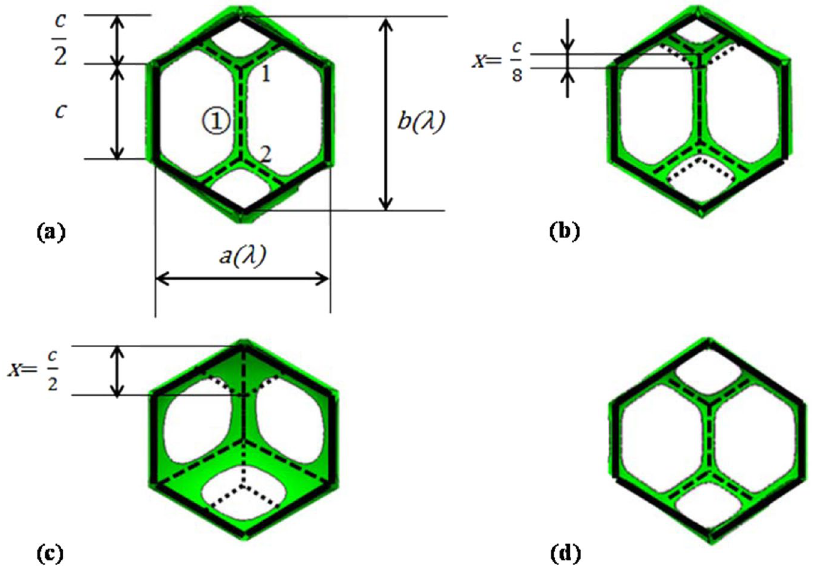
Figure 8. Sketches of top views of local configurations of Tóth, Tóth-like and honeycomb-like structures cell in the Evolver model: ( a ) Perfect Tóth structure. Here, x = 0, α = 0, λ = 1, ϕ liq = 0.50%. ( b ) Tóth-like structure. Here, x = c/8 , α = 0.25, λ = 1, ϕ liq = 0.50%. ( c ) Honeycomb-like structure. Here, x = c/2 , α = 1, λ = 1.05, = 2.40%. ( d ) Tóth-like structure. Here, x = 0 , α = 0, λ = 1.1, ϕ ϕ liq interface films are not shown, just the green Plateau border for clarity.